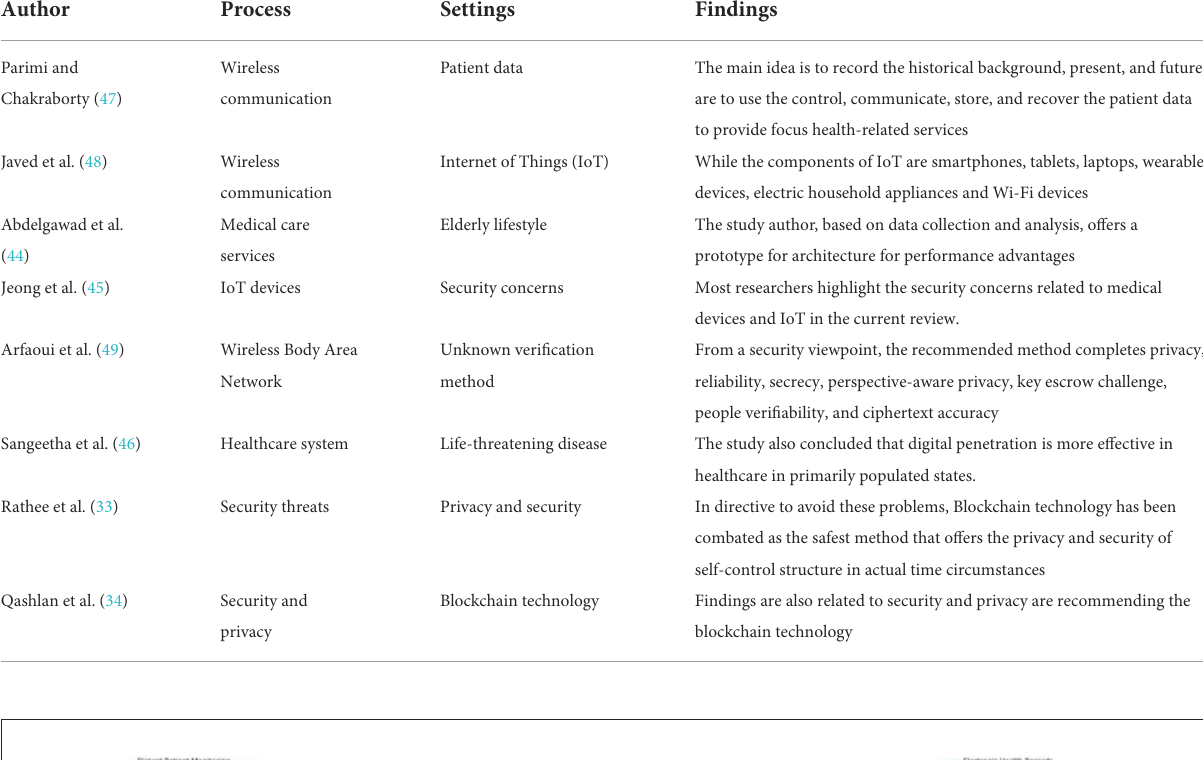
TABLE 6 Internet of things (IoT) in healthcare.